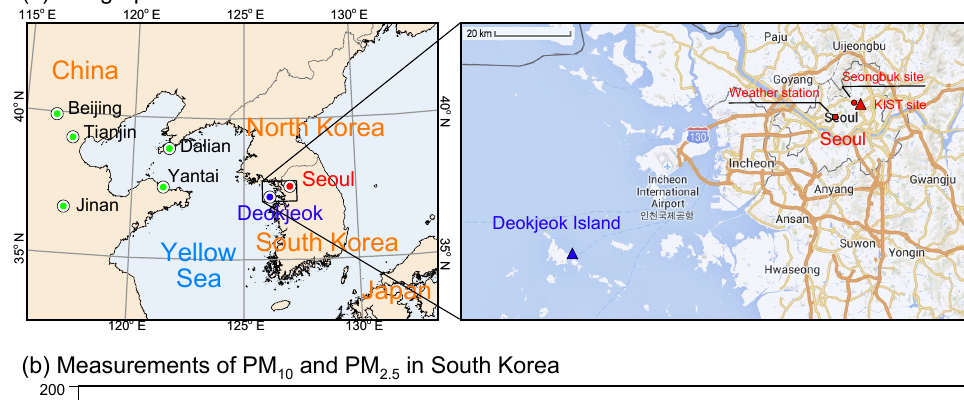
relevant synoptic conditions that induced the multiday haze event are further